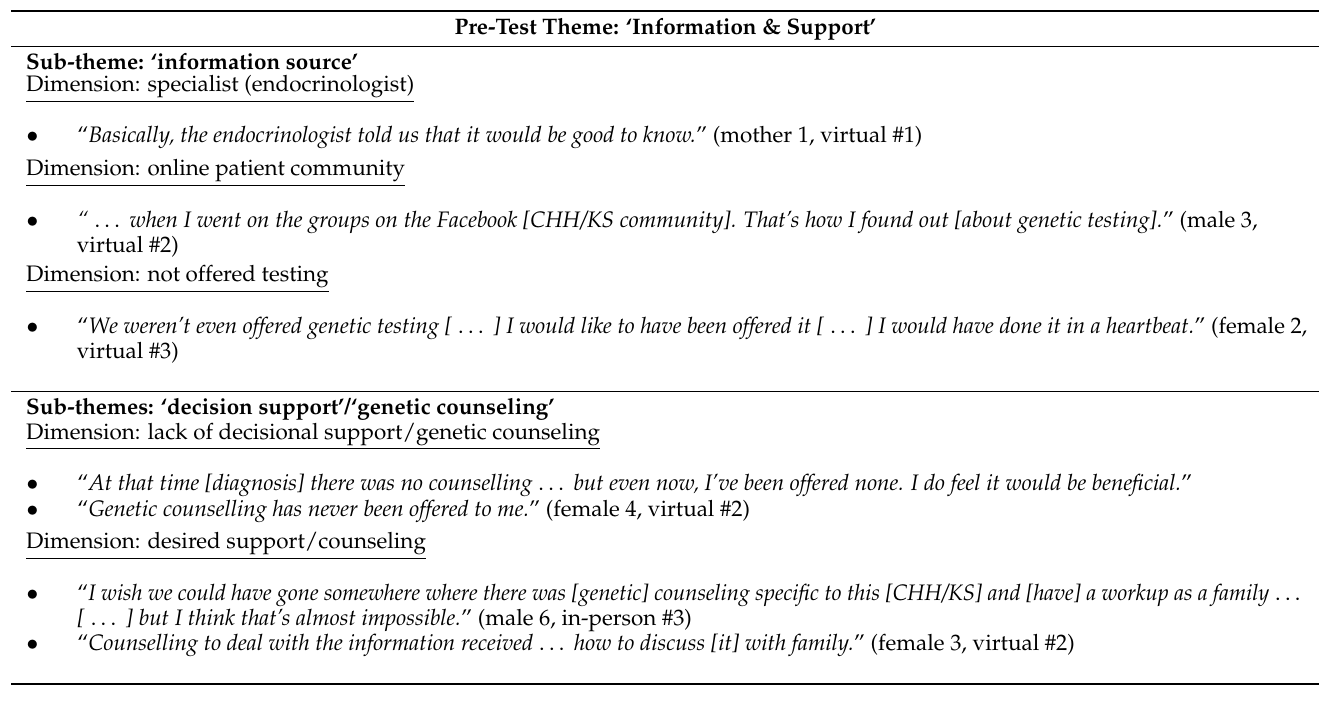
Table 3. Representative quotes relating to pre-test experiences: ‘information &